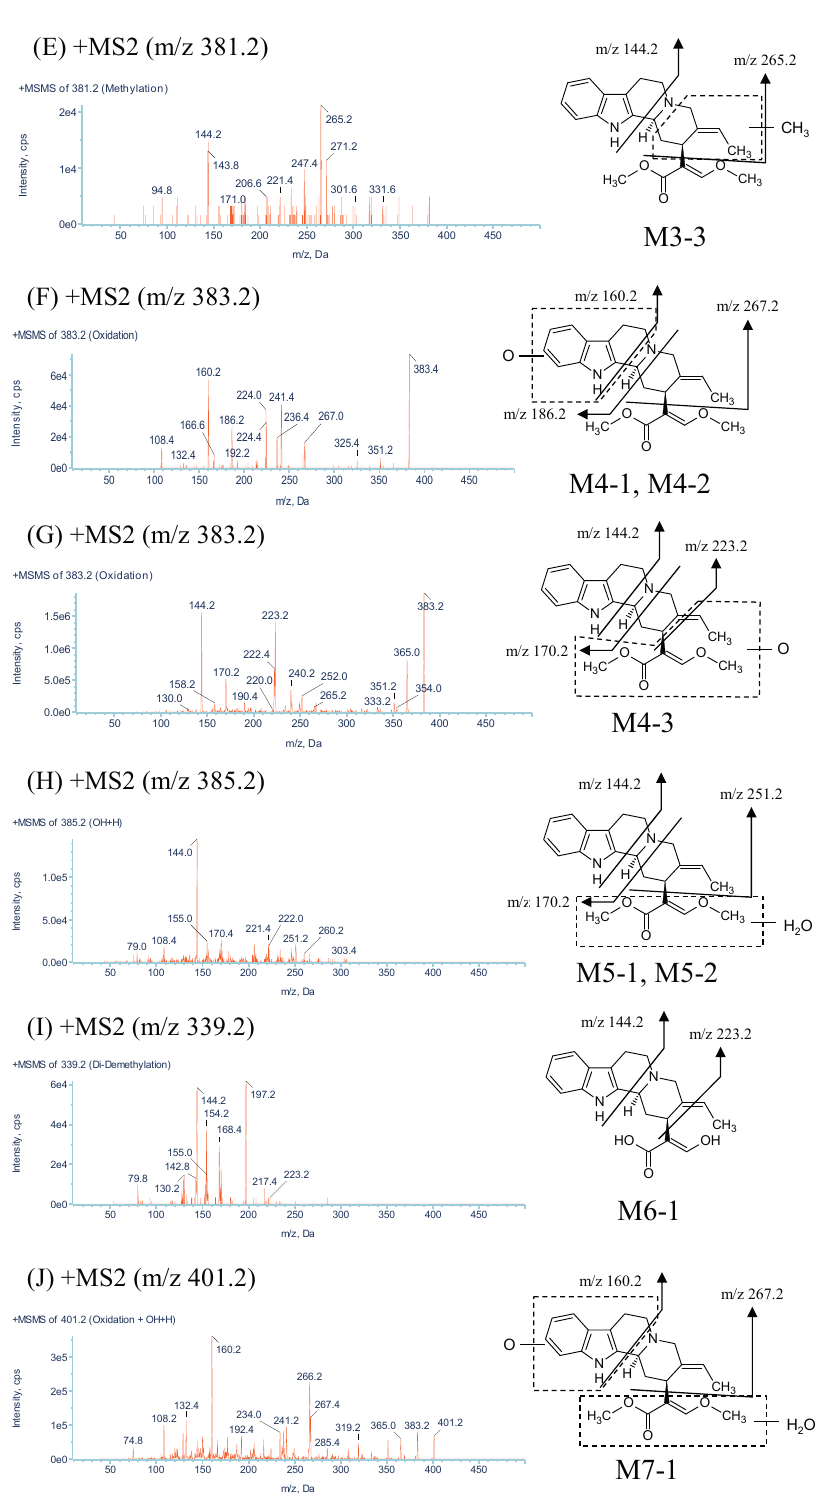
Figure 3. MS 2 spectra of GM and its metabolites. ( A ) GM; ( B ) methylation metabolite (M1-1); ( C ) dehydrogenation metabolite (M2-1); ( D ) methylation metabolites (M3-1 and M3-2); ( E ) methylation metabolite (M3-3); ( F ) oxidation metabolites (M4-1 and M4-2); ( G ) oxidation metabolite (M4-3); ( H ) water-adduct metabolites (M5-1 and M5-2); ( I ) di-demethylation metabolite (M6-1); and ( J ) water-adduct metabolite followed by oxidation (M7-1) of